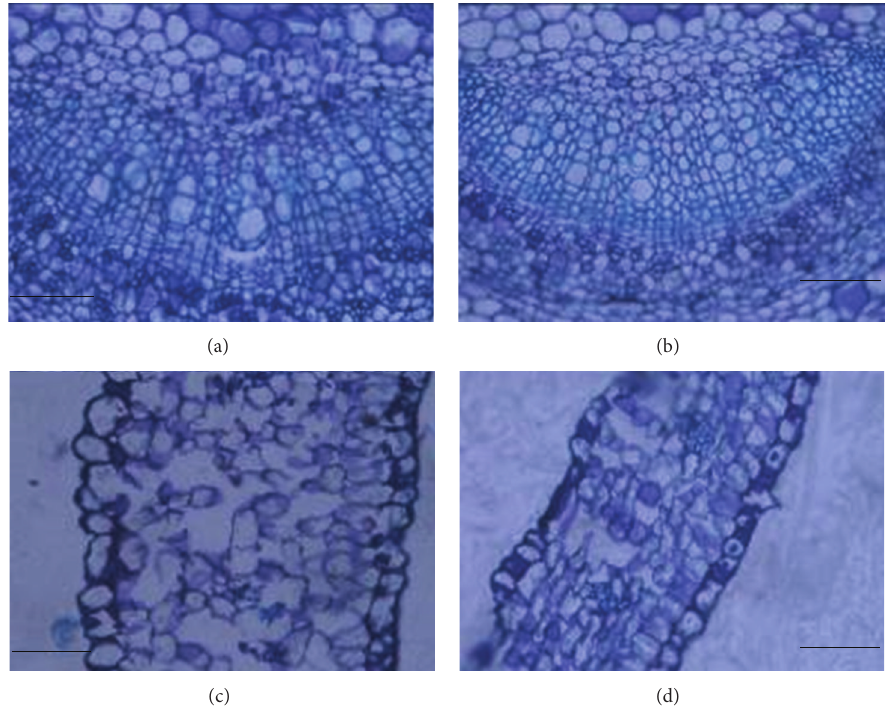
Figure 4: Comparison of root and leaf transections between PY and FD after 2 weeks of 0.3 mM fluoride (F) treatment. (a) and (c) represent midrib regions and leaf lamina, respectively, in PY; (b) and (d) represent midrib regions and leaf lamina, respectively, in FD. Scale bar = 100 𝜇 m in (a) and (b); scale bar = 25 𝜇 m in (c) and (d). PY: “Pingyangtezao” tea cultivar; FD: “Fudingdabai” tea